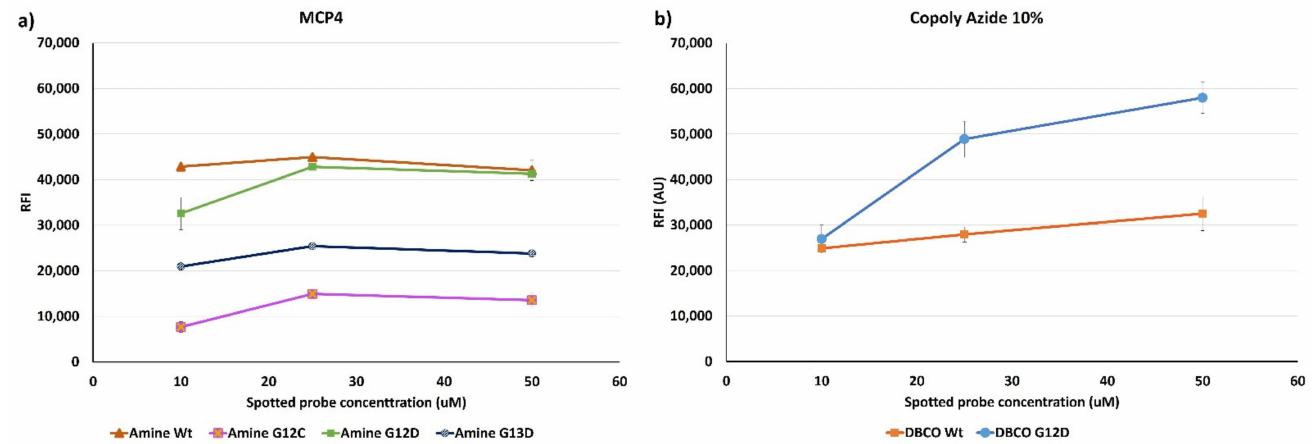
Figure 7. Fluorescence signal intensities obtained after hybridization of the spotted probe with a synthetic ssPCR. Fluores- cence detection has been obtained using a Cy3-labelled oligonucleotide (U-Cy3) complementary to the U-tag sequence at 5’-end of the synthetic ssPCR. The same experiment was performed on ( a ) MCP-4 coated chips, onto which amine modified oligonucleotide were immobilized, and on ( b ) Copoly Azide 10% Coated chips; in this case DBCO modified probes were used. Fluorescence was detected using a confocal laser scanner, setting the power to low and the gain to